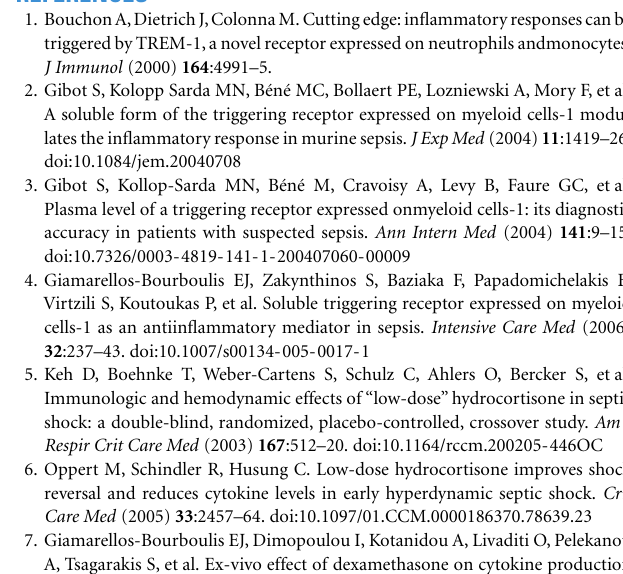
FIGURE 6 | Model for the mechanism of action of dexamethasone . After infection with Gram-negative bacteria like P. aeruginosa , endotoxin (LPS) induces production of theTREM-1 receptor. Membrane-bound TREM-1 can be proteolytically processed, resulting in release of sTREM-1 into the extracellular space. Dexamethasone (DEX)